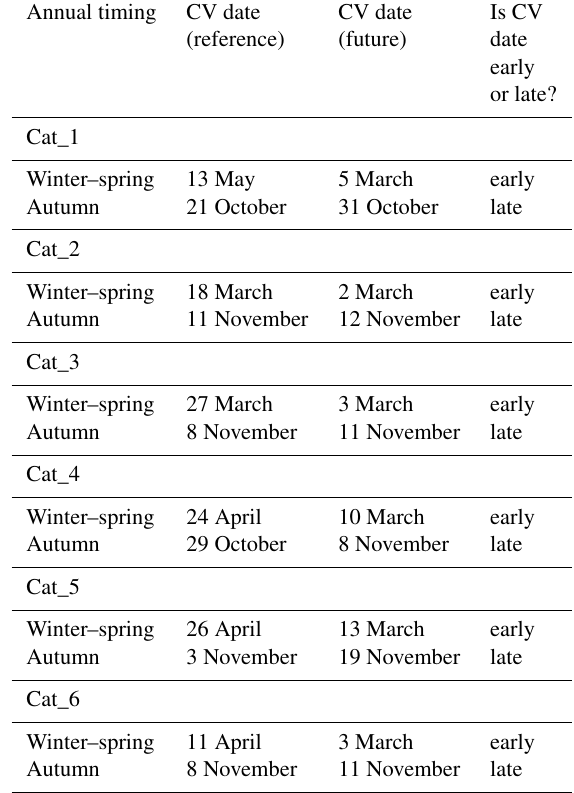
Table 5. Changes in percentage of mean annual flow and seasonal flows for the study catchments.